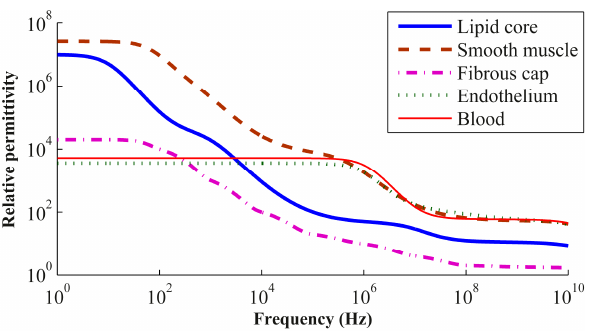
Figure 4. Relative permittivity versus frequency for the blood and neointimal tissues.